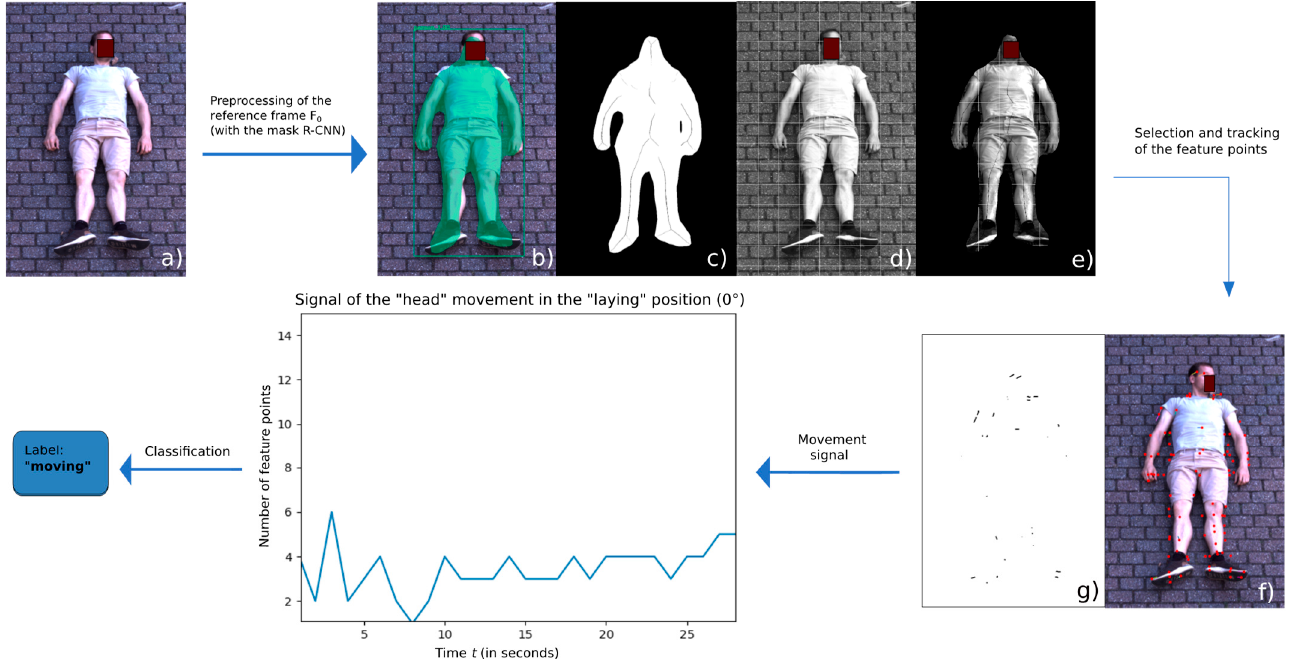
Figure 3. Intermediary RGB images throughout the algorithmic process: ( a ) the original RGB frame, ( b ) the mask and bounding box given from mask R-CNN, ( c ) the binary skeletonized mask, ( d ) the white grid on the gray image, ( e ) the processed image prepared for the selection of feature points, ( f ) the selection of feature points, and ( g ) the movement lines in between two frames of the feature points (essentially “head” movement). The obtained movement signal through time is displayed in the graphic, and, in this case, the person is classified as “moving”.